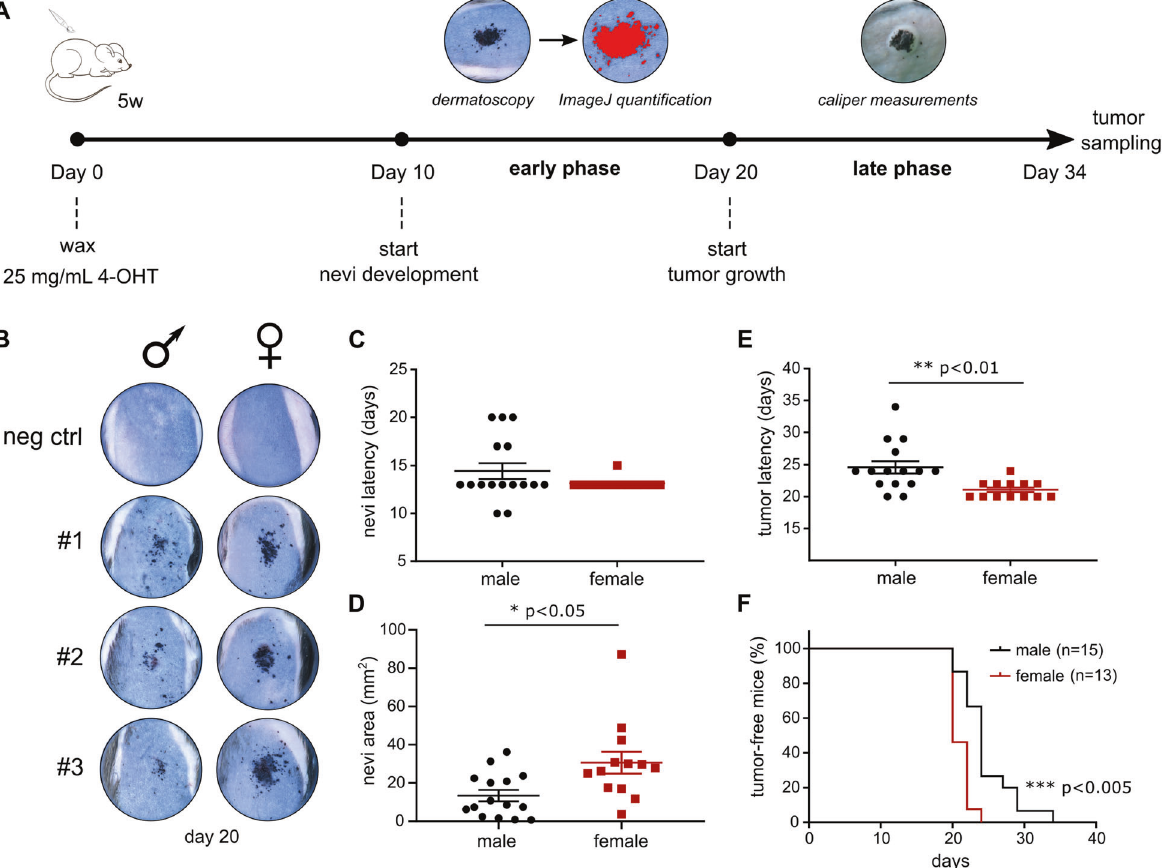
Fig. 1 Female mice develop faster melanoma than male mice in the Mlkl + / + Braf V600E Pten − / − melanoma mouse model. A All age-matched mice (5 weeks) ( Tyr::CreERT2 + / + or tg/ + ;Mlkl + / + or − / − ;Braf V600E tg/ + ;PTEN fl / fl ) were waxed, followed by topical application of 1.5 µL 4-OHT (25